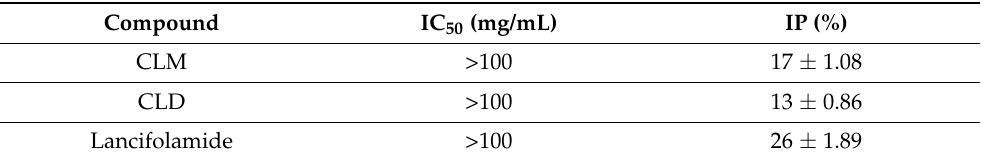
Table 7. Anti-HSV-1 extract activities along with lancifolamide compound secluded from C. lancifolius . Mean ± SD (n = 3).